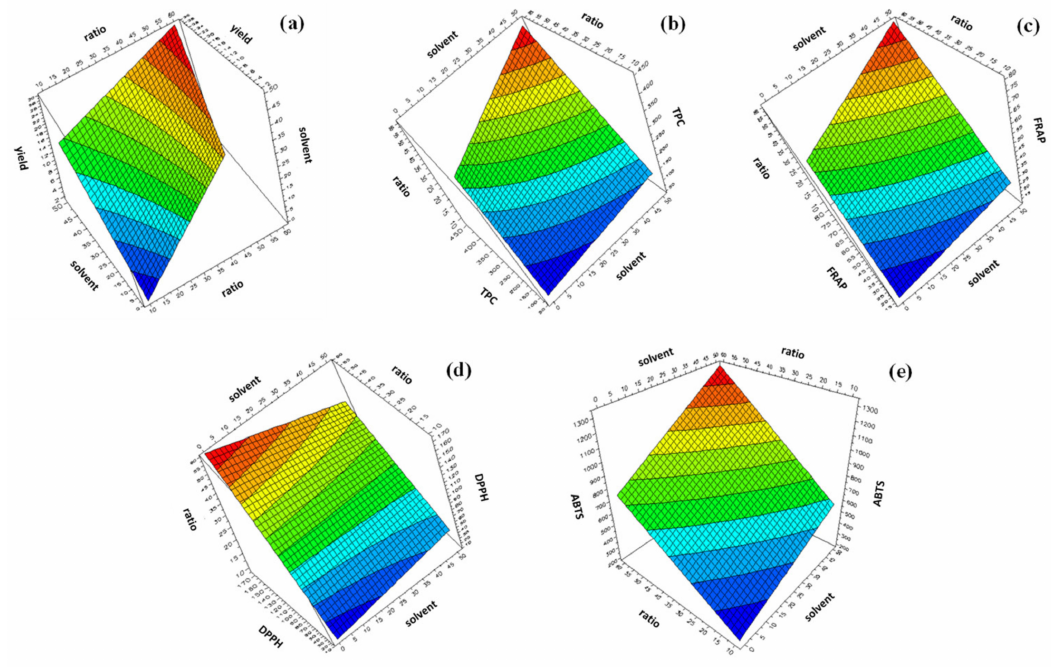
Figure 2. Surface plots for the responses: ( a ) yield, ( b ) TPC, ( c ) FRAP, ( d ) DPPH, ( e )